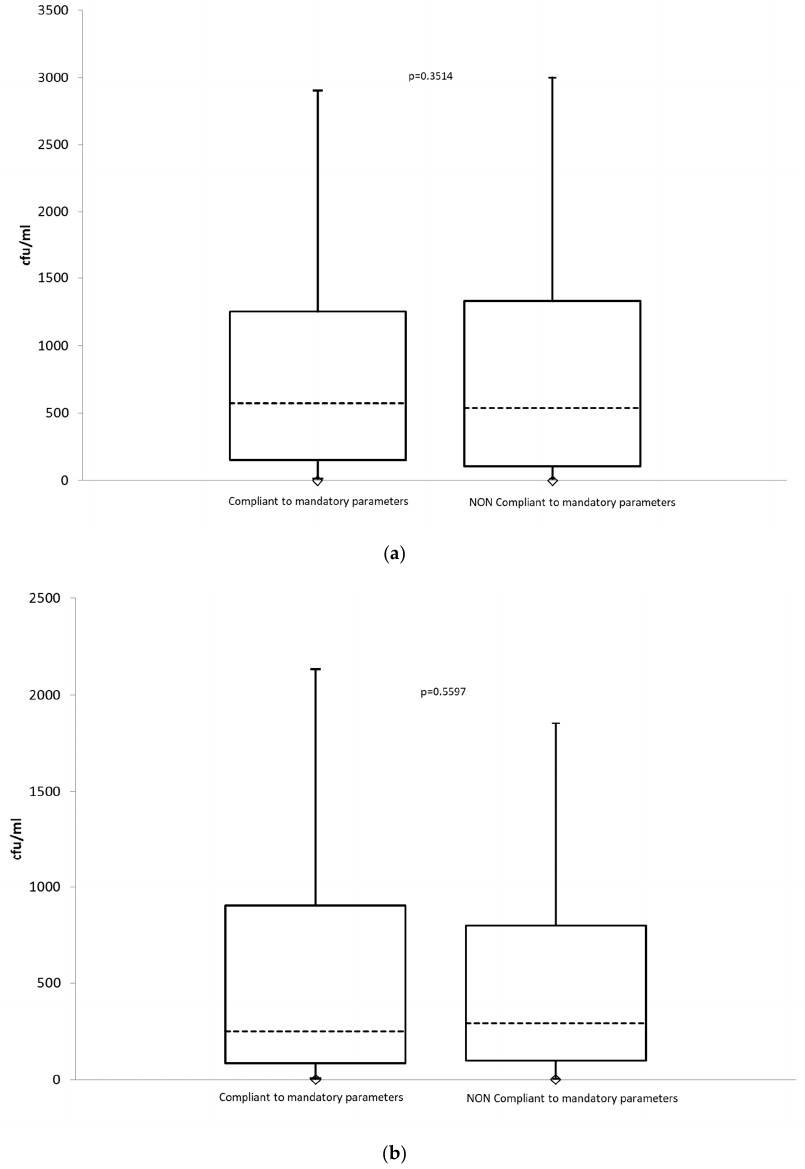
Figure 2. ( a ) Box-plot to compare microbial counts at 22 ◦ C between compliant and non-compliant samples to mandatory parameters. ( b ) Box-plot to compare microbial counts at 37 ◦ C between compliant and non-compliant samples to mandatory